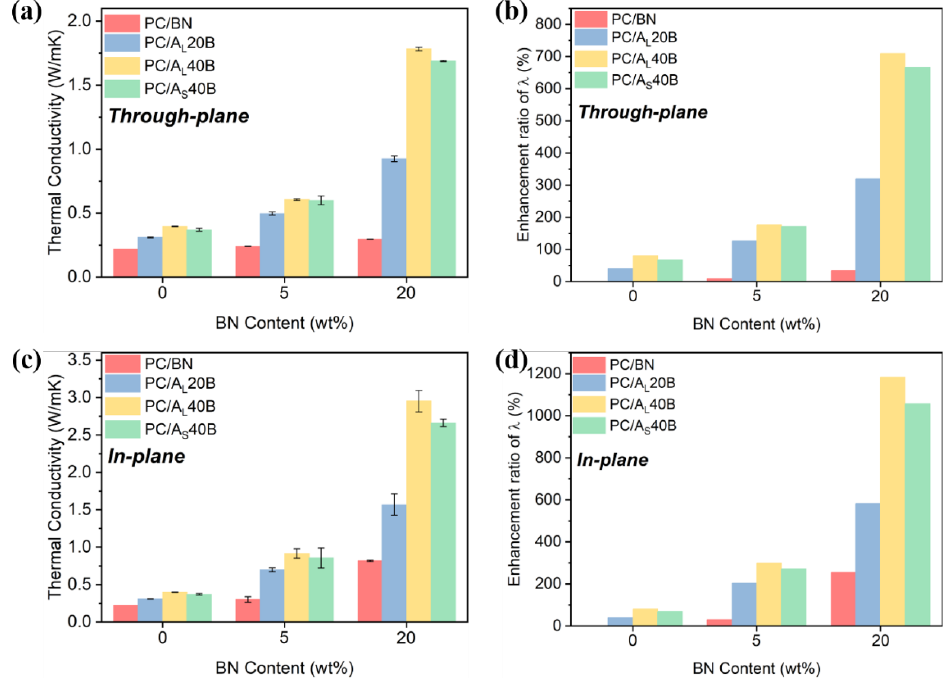
Figure 3. ( a ) Through-plane λ , ( b ) through-plane λ enhancement ratio, ( c ) in-plane λ , and ( d ) in- plane λ enhancement ratio of PC/Al 2 O 3 /BN composites with different Al 2 O 3 particle sizes and con- tents.